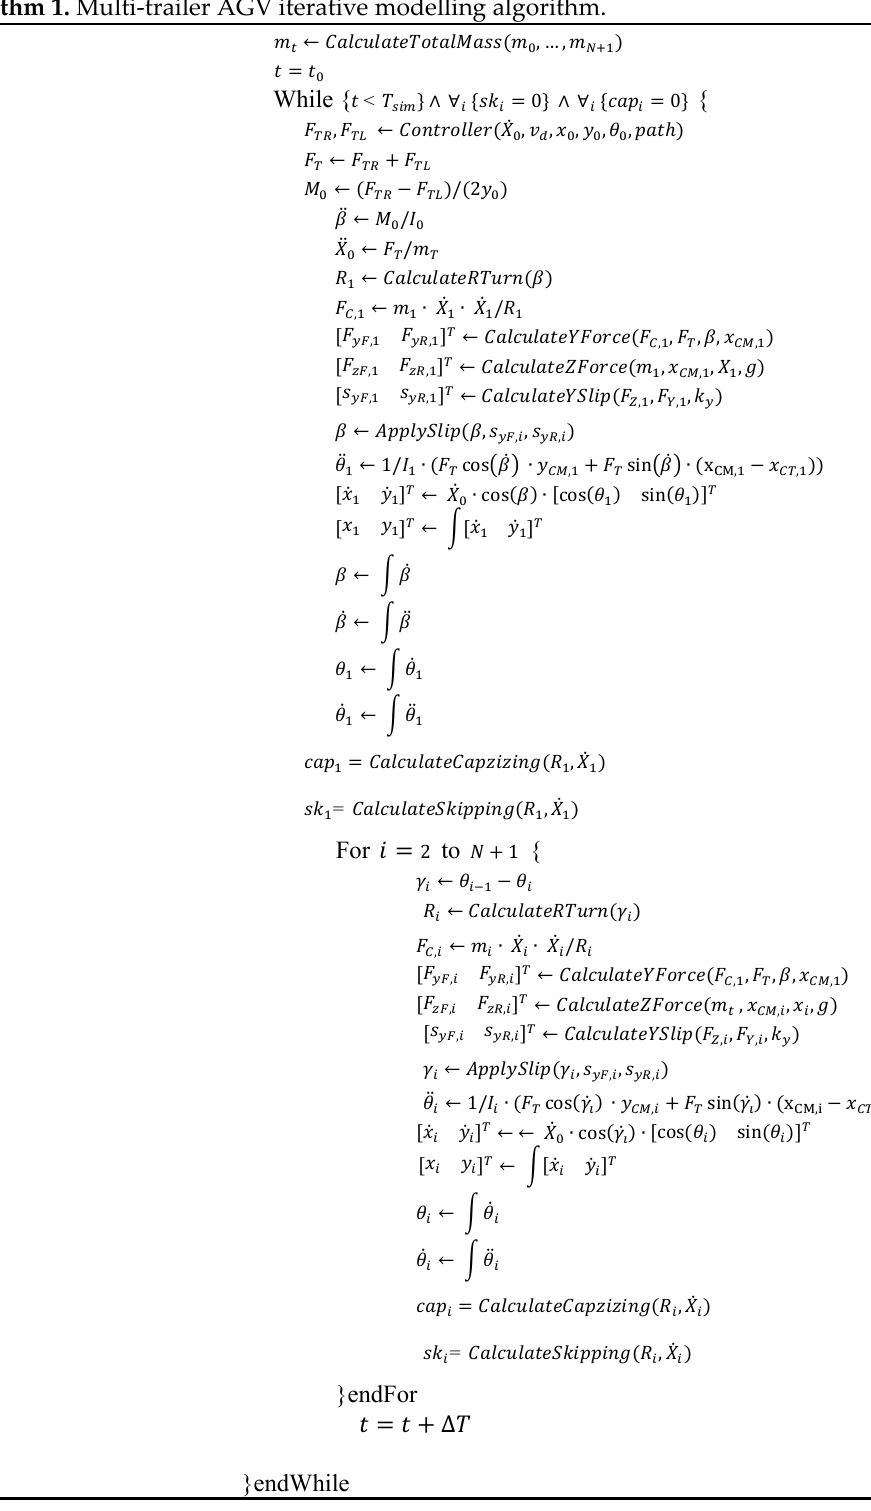
Algorithm 1. Multi-trailer AGV iterative modelling